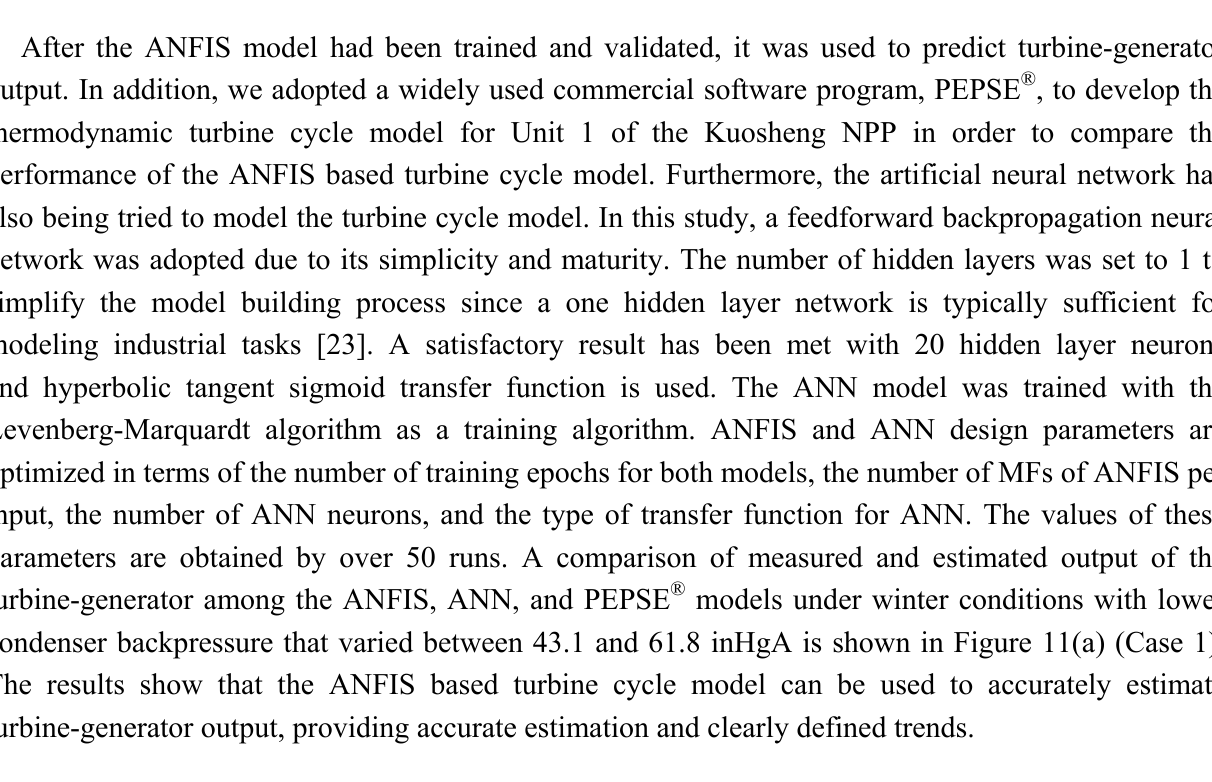
Figure 11. ( a ) Estimated results under winter operating conditions (Case 1); ( b ) Estimated results with wider variations in condenser backpressure (Case